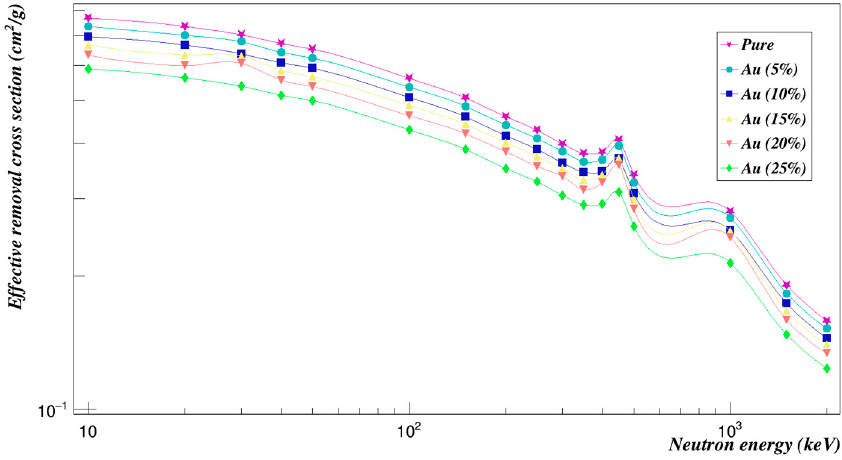
Figure 15. Neutron e ff ective removal cross sections of Polyimide doped with gold.